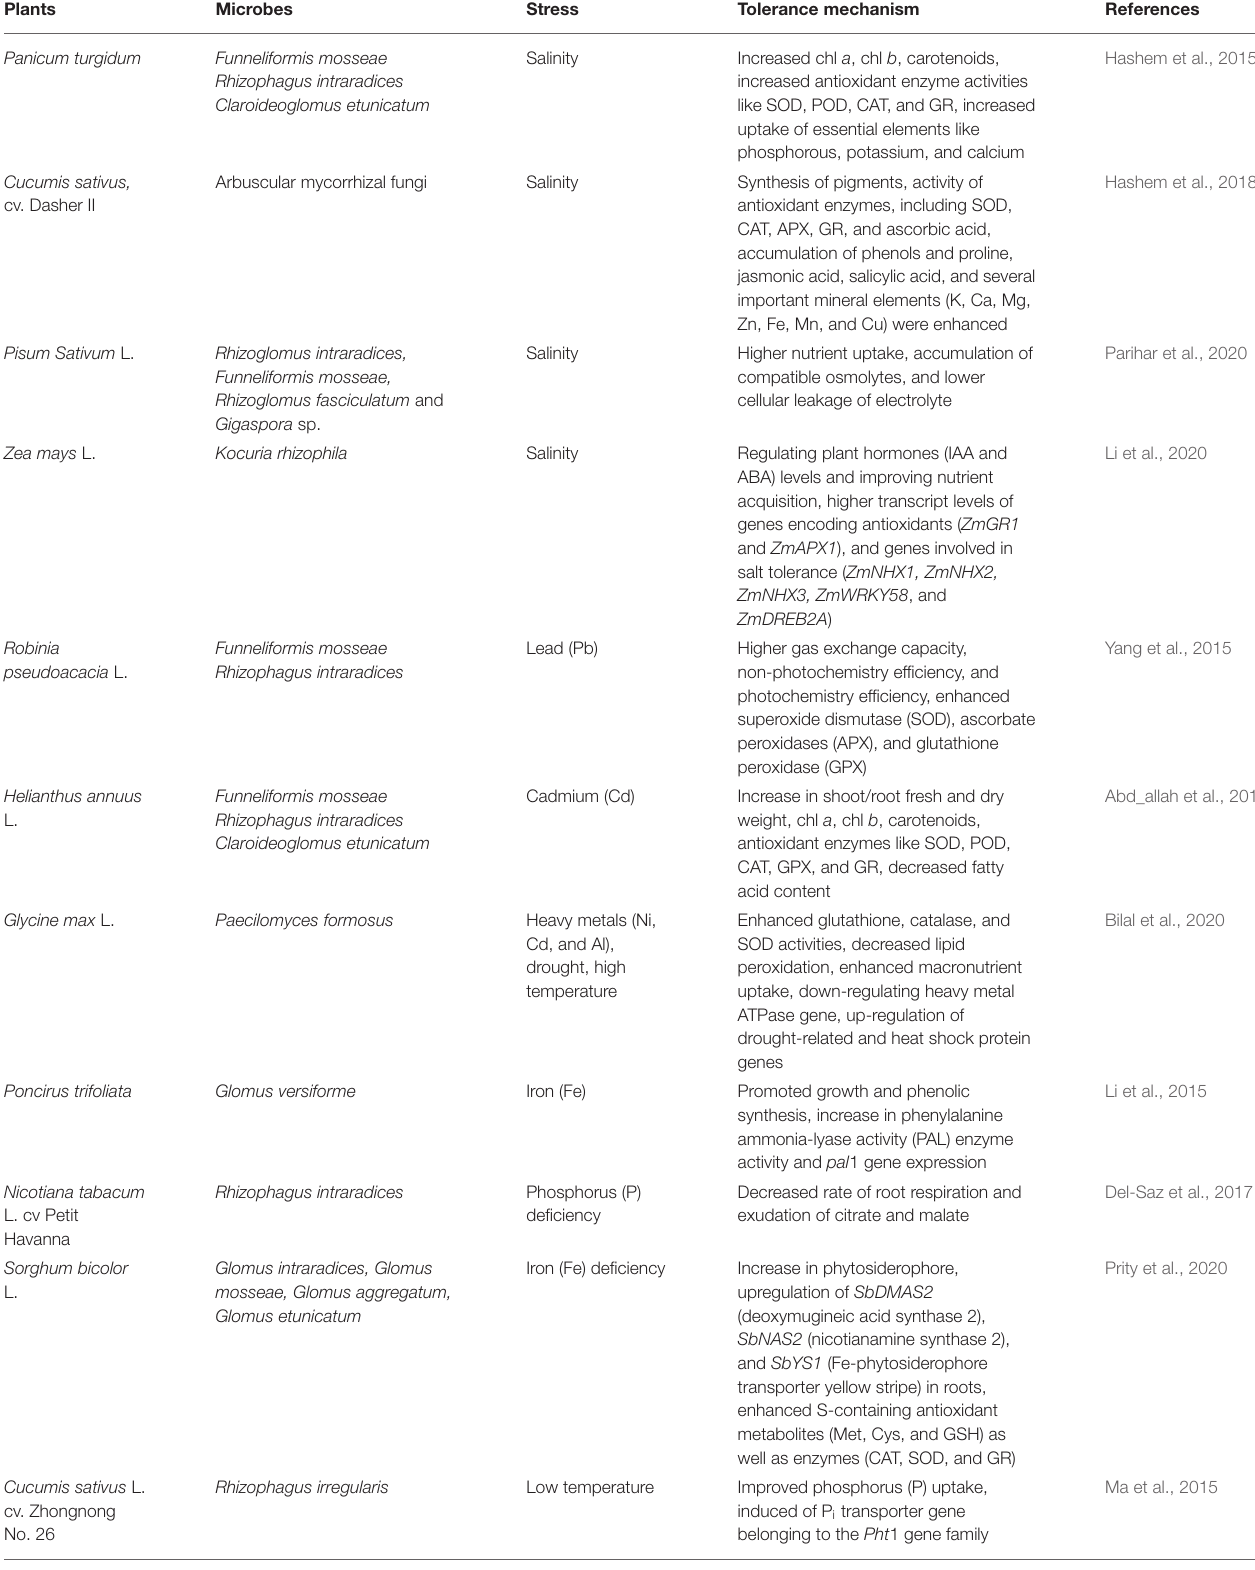
TABLE 1 | Microbial mediated abiotic stress